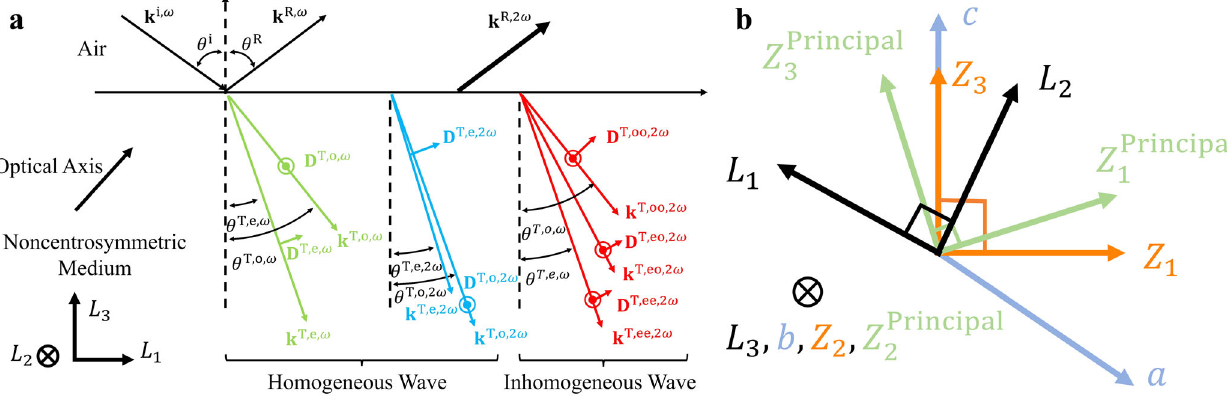
o polarization states are de fi ned as the dielectric displacement ( D ) with a component along (e) or perpendicular to (o) the optical axes (0 optical axes for anaxial, 1 for uniaxial, and 2 for biaxial crystals). The extraordinary wave (e) is normal to D o (ordinary polarized dielectric displacement) 27 . The other superscripts, i, R, or T, corresponding to the incident, re fl ected, or transmitted beams, respectively. The angle θ represents the propagating angle of the associated wave with the wave vector k . Four different coordinate systems shown in Fig. 2b are